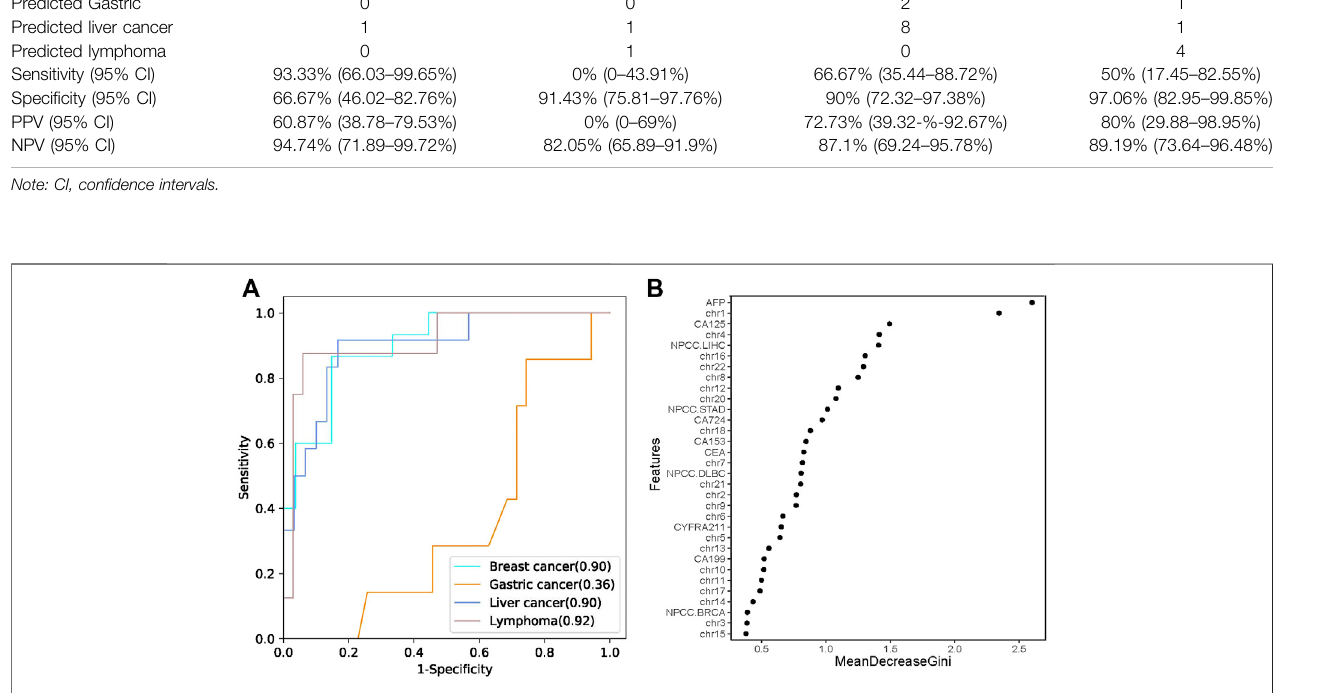
Frontiers in Genetics |